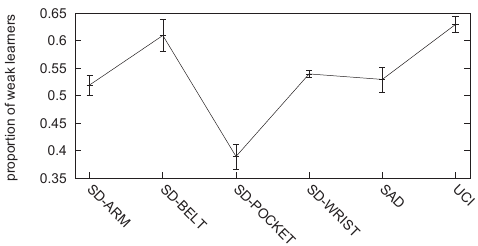
Figure 7: Comparison with noBelief and noExtra in terms of f-score.